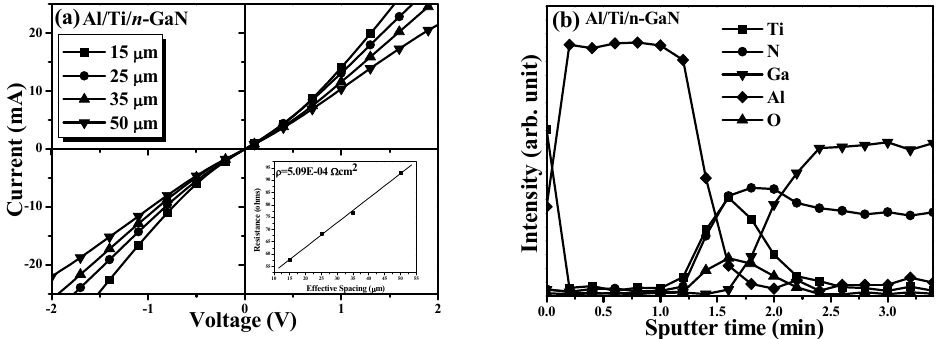
Figure 4. ( a ) I-V curve of the as-deposited metallic Ti/Al system’s contact to n -GaN epilayer Figure 4. ( a ) I ‐ V curve of the as ‐ deposited metallic Ti/Al system’s contact to n ‐ GaN epilayer and ( b ) and ( b ) the elemental distribution of the Al/Ti/ n -GaN contact system conducted from AES depth the elemental distribution of the Al/Ti/ n ‐ GaN contact system conducted from AES depth profile profile measurement.